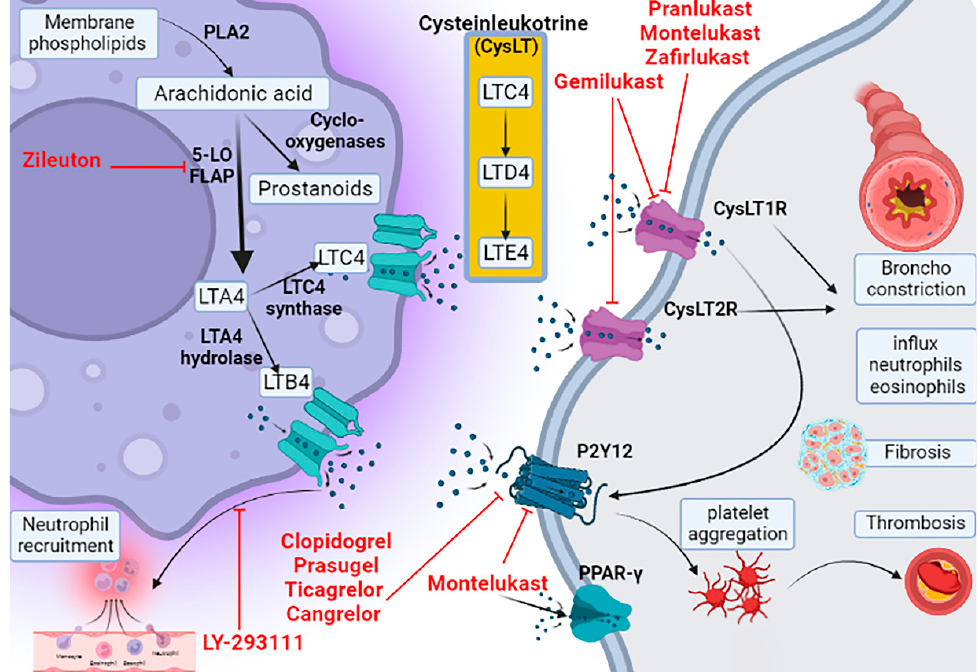
Figure 1. Leukotriene pathway and its inhibitors: Membrane phospholipids hydrolyzed by phos- pholipase A to arachidonic acid (AA), which, by the action of 5-lipoxygenase (5-LO), convert to leukotriene A4 (LTA4). Further, LTA4 is converted to LTB4 by the action of LTA4 hydrolase and to cysteinleukotriene (CysLT) by the action of LTC4 synthase. CysLTs act on CysLT receptors (CysLT1R and CysLT2R).